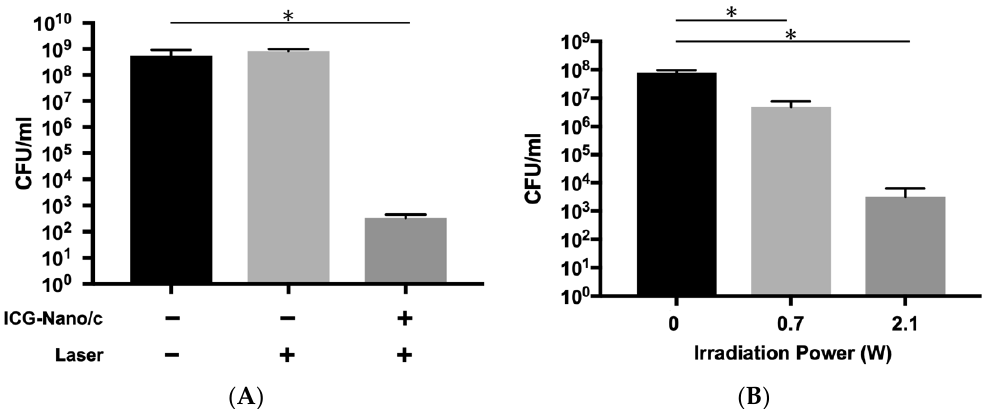
Figure 2. Confirmation that the bactericidal effect is due to aPDT/PACT. ( A ) Comparison of bactericidal effects with and without photosensitizers. The laser was applied at 2.1 W (1.46 W/cm 2 ) for 5 min without air-cooling. A sufficient bactericidal effect could not be obtained in the absence of photosensitizers. ( B ) Bactericidal effect with air-cooling (2 L/min). A marked bactericidal effect was obtained, even when air-cooling reduced the effect of heat. Data are presented as mean ± standard deviation. Asterisks (*) denote p < 0.05 ( n = 3).